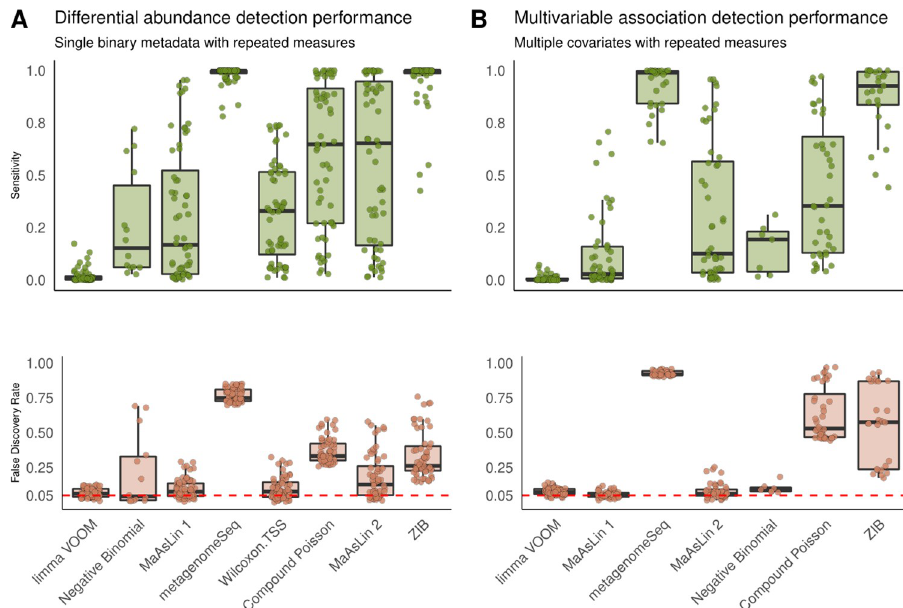
Fig 4. MaAsLin 2 enables targeted microbial feature testing in the presence of repeated measures. Results on simulated data comprising SparseDOSSA-derived compositions with five repeated measures per sample. The FDR is close to the target 0.05 level for MaAsLin 2’s default linear model but not for zero-inflated and count models (full results in S1–S8 Data ). As before, MaAsLin 2’s linear model is consistently better powered than both negative binomial and limma VOOM at comparable FDR values, which remains consistent for both univariate continuous metadata ( A ) and multivariable metadata designs ( B). The red line parallel to the x-axis is the given threshold for FDR in multiple testing. Within each panel, methods are sorted by increasing order of average F1 score across all associated simulation parameters in each setting.